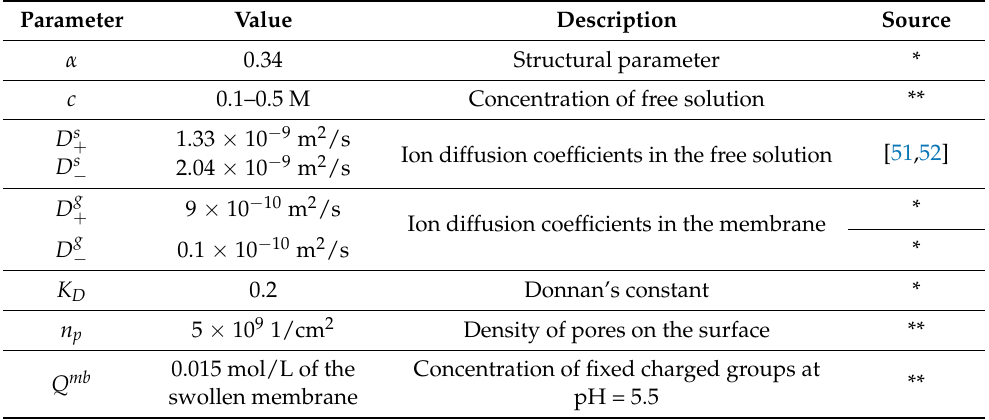
Table 2. Input parameters used in the calculation of the conductivity and diffusion permeability of the